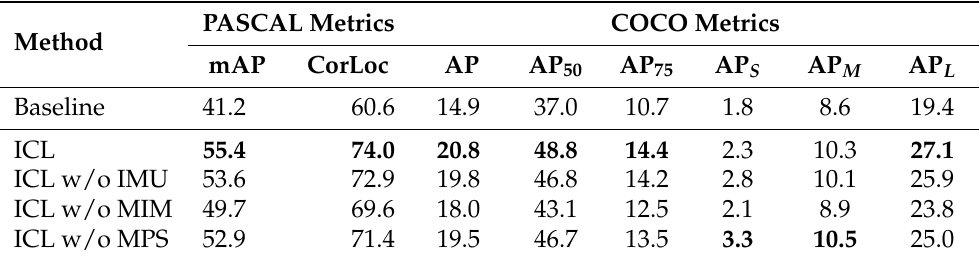
Table 4. The contribution of each component of our method. Both PASCAL metrics and COCO metrics are